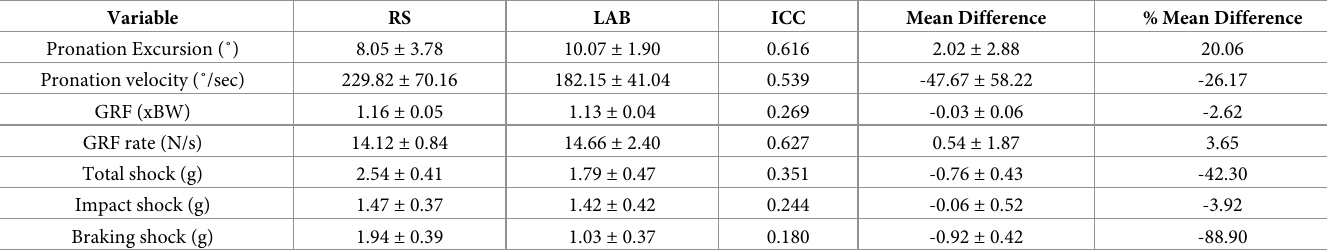
Table 2. Comparison of all variables with data from both limbs combined (Mean ± SD), with ICC and mean differences (LAB–RS). Variable